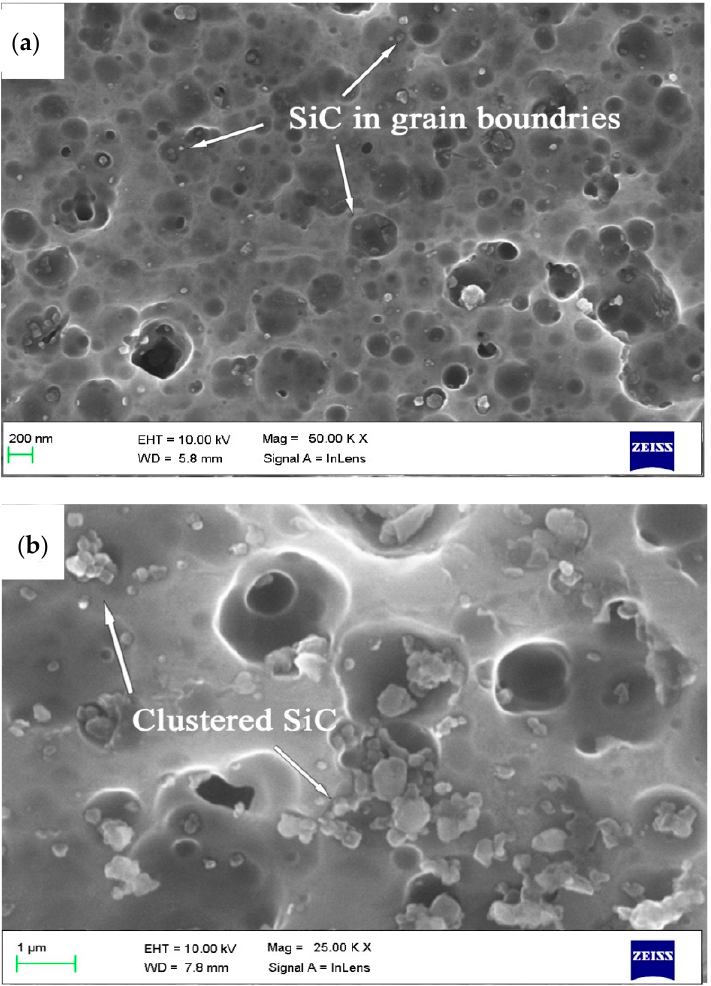
Figure 8. FESEM images of the SZs of the FSSW joints: ( a ) AA5083/nano-SiC, and ( b ) AA5083/micro-SiC.